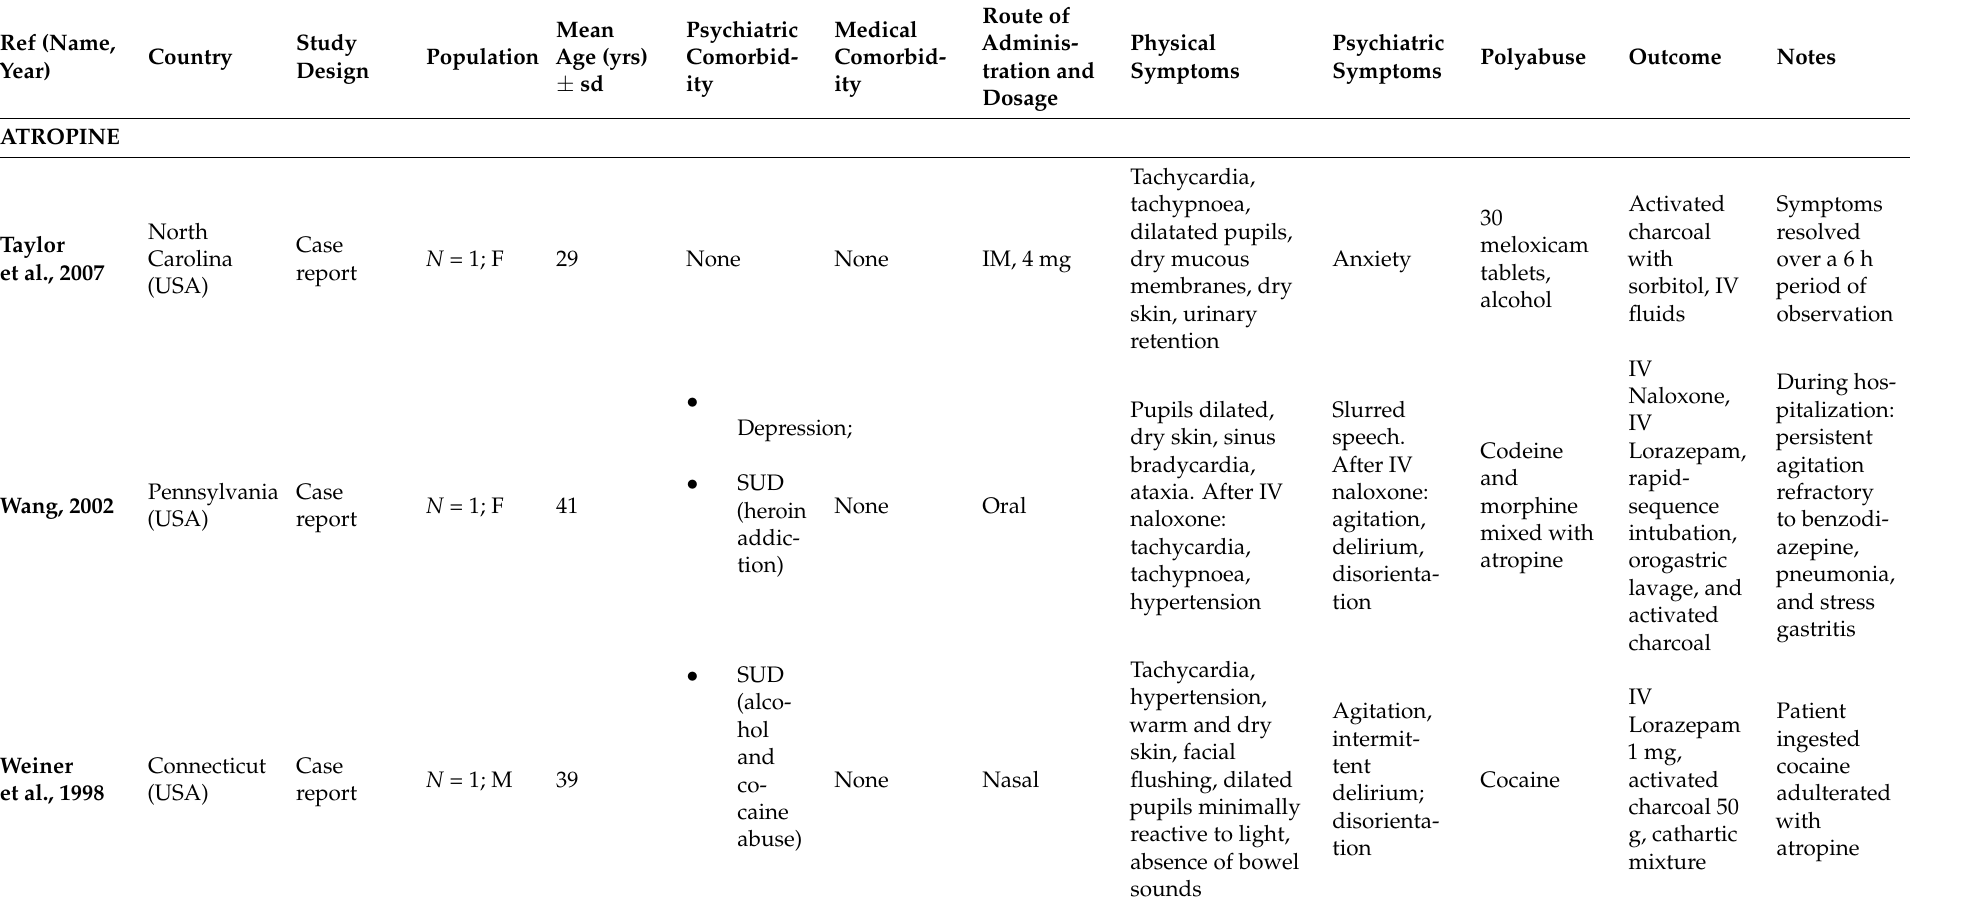
Table 1. Main findings of retrieved